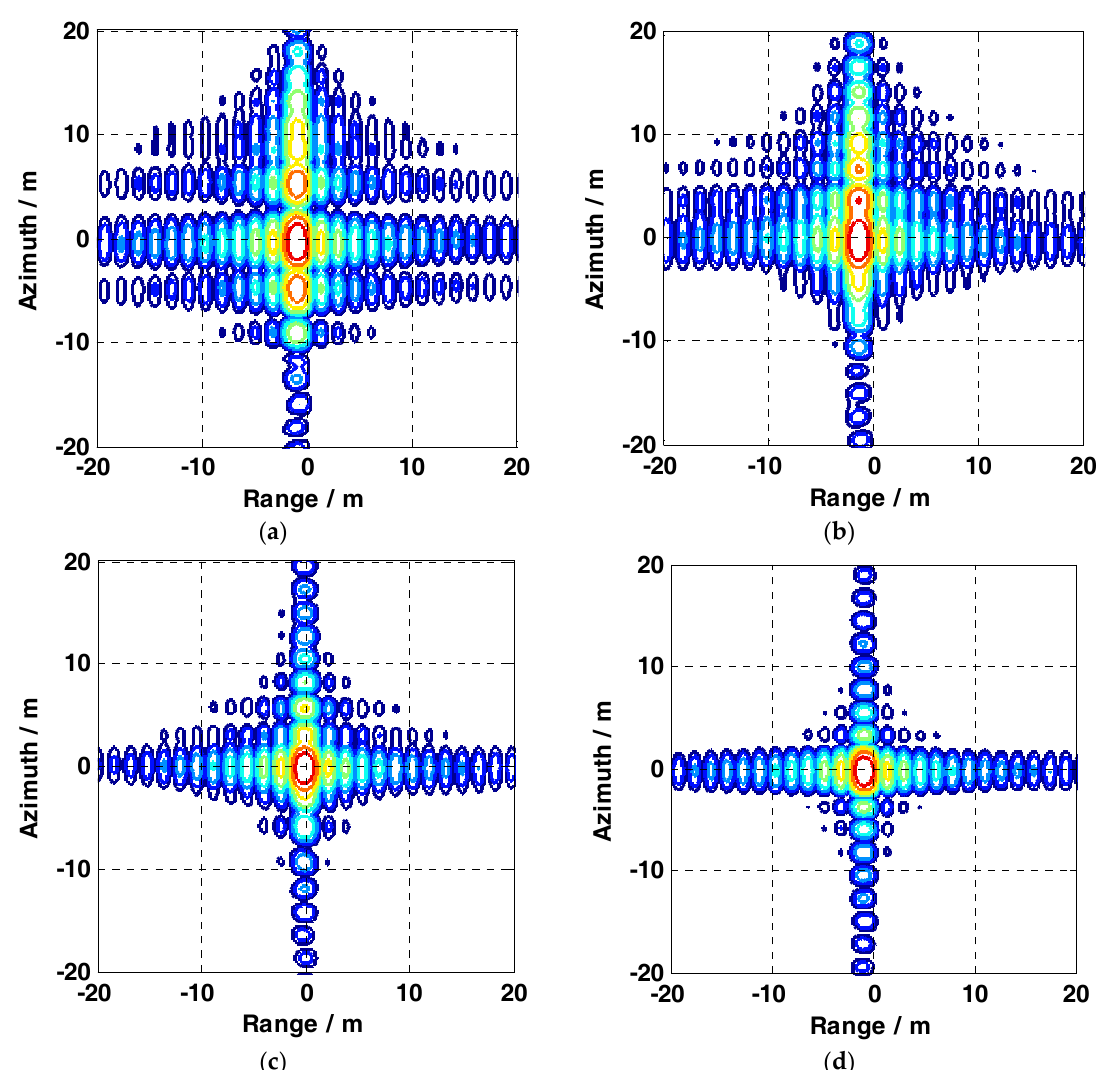
Figure 5. Target 5’s contours processed by ( a ) the conventional SAR imaging algorithm (CS algorithm), ( b ) MD algorithm, ( c ) PGA algorithm, and ( d ) BLUE algorithm, for strip-map SAR data with intensive accelerated motion error.